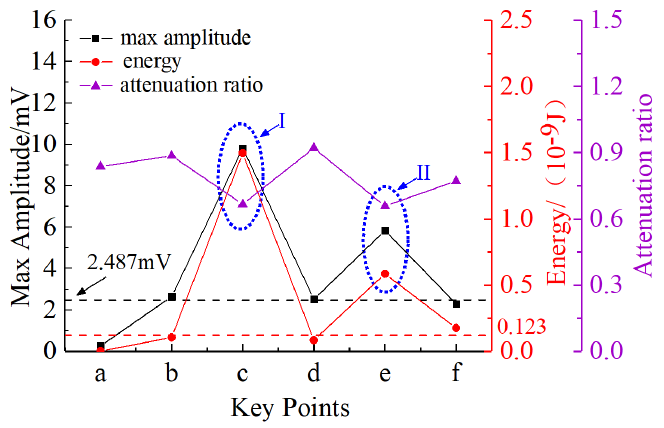
Figure 9. The characteristics of waveforms’ time–domain parameters diagram of the key points.